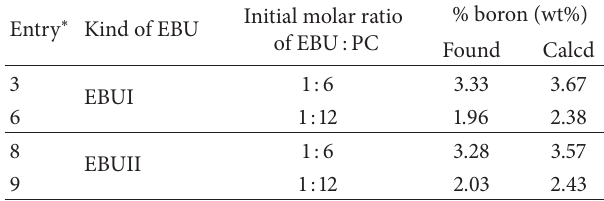
Table 3: Boron percentage in obtained